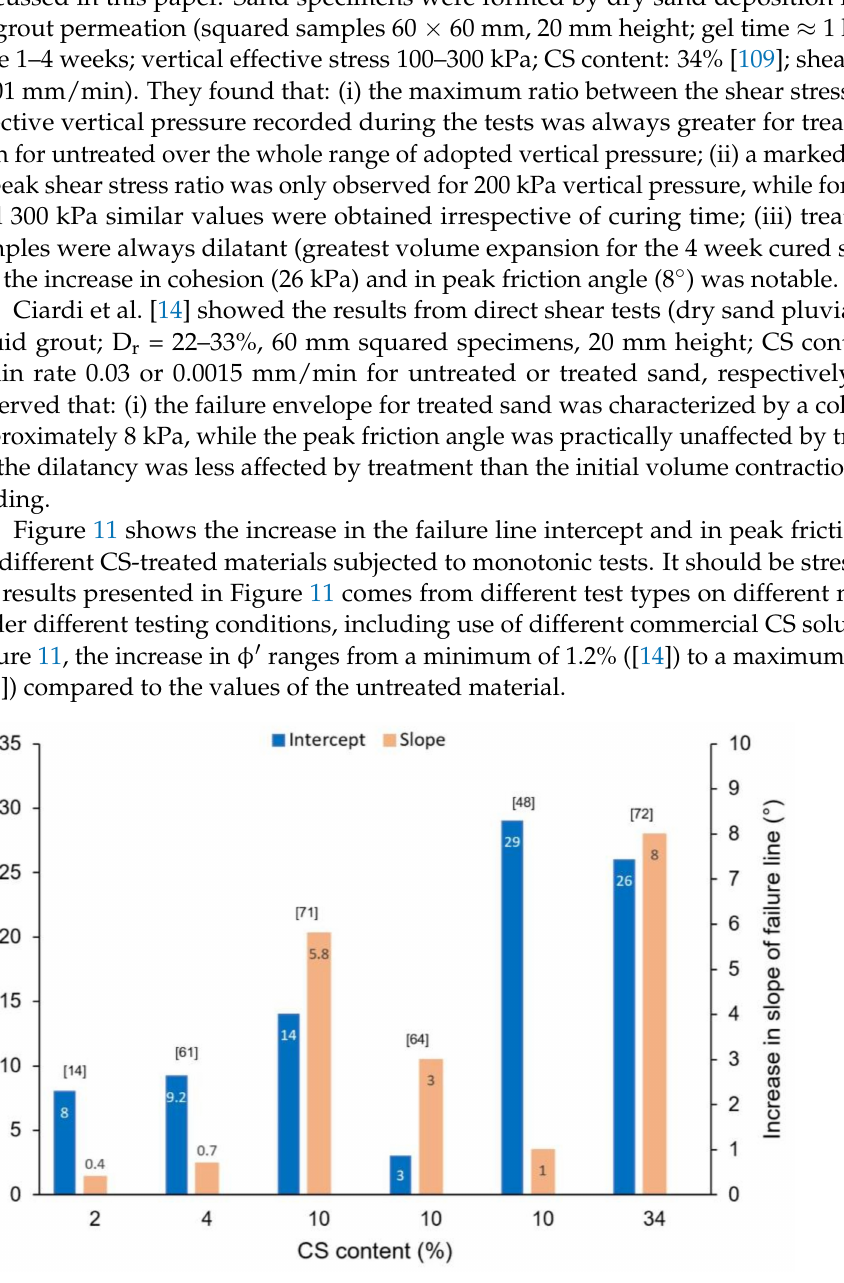
Figure 11. Increase in failure line intercept (left axis) and internal friction angle (right axis) after monotonic tests (data collected from the references in the plot; data from triaxial tests for [71] for normal effective stress < 200